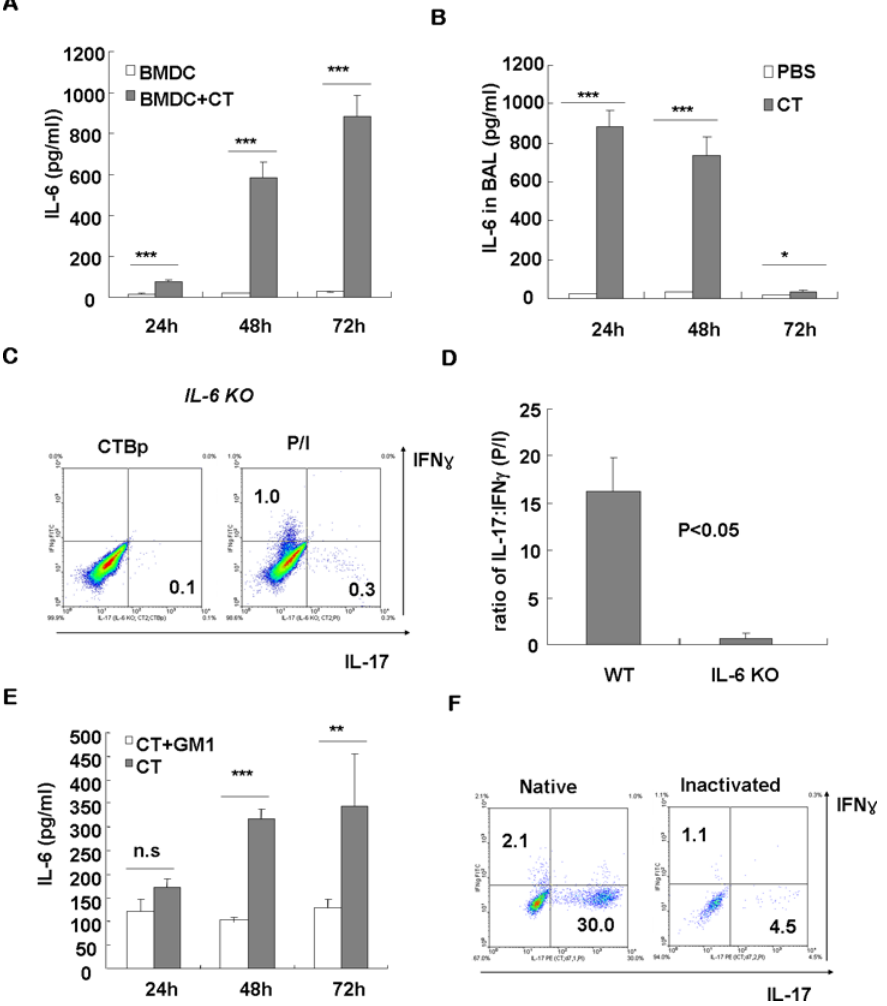
Figure 5. CT induces IL-6 production invitro and invivo , which is required for Th17-driving activity. (A) Dendritic cells were generated from bone marrow of BALB/c mice by culturing with GM-CSF and IL-4. After 6 days, DCs were purified and cultured in the presence or absence of CT. At indicated time points, the levels of IL-6 cytokine in the supernatant were determined by ELISA. (B) B6 mice were intranasally injected with 2 m g of CT and BAL samples were prepared at indicated time points. The levels of IL-6 in the BAL fluids were measured by ELISA. (C, D) IL-6KO mice with B6 background were intranasally injected with CT, and lung mononuclear cells were prepared at day 7 and IL-17- and IFN- c -producing CD4 T cells were measured by ICS upon stimulation. (E) For blocking experiment, CT was pre-incubated with 5-fold molar excess of ganglioside GM1 and then added to the DC culture. Data are average 6 SEM, and representative of two experiments. (F) CT was heat-inactivated by boiling for 30 min and intranasally administered into normal B6 mice. At day 7, lung tissues were isolated, stimulated with PMA/ionomycin, and stained for CD4, IFN- c , and IL-17. *, P , 0.05; **, P , 0.01; ***, P , 0.001; n.s., not significant.